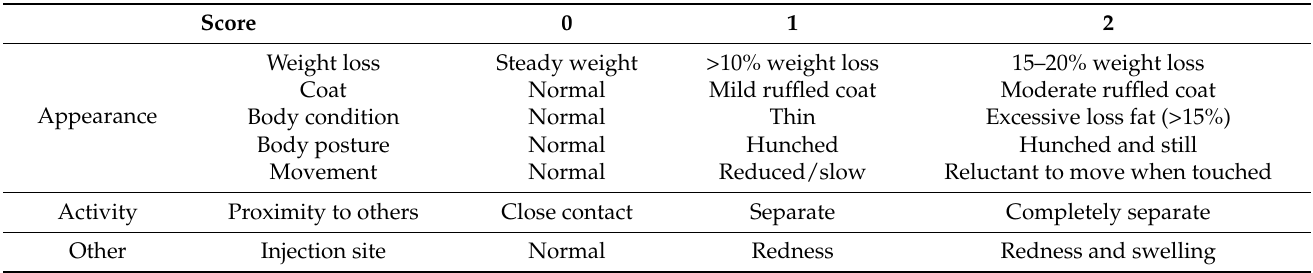
Figure 6. ( A1 ) First MTD methodology for part -CaF 2 . The doses were incremented by no more than 50% from the initial dose over 10 days. ( B1 ) Second MTD methodology for part -CaF 2 . The doses were doubled every day starting at 1.00 mg·kg − 1 . ( A2 , B2 ) For both methodologies, the weight loss was monitored for the control and intervention groups of 5 mice each. Table 1. Dose escalation decision of MTD for clinical observations.